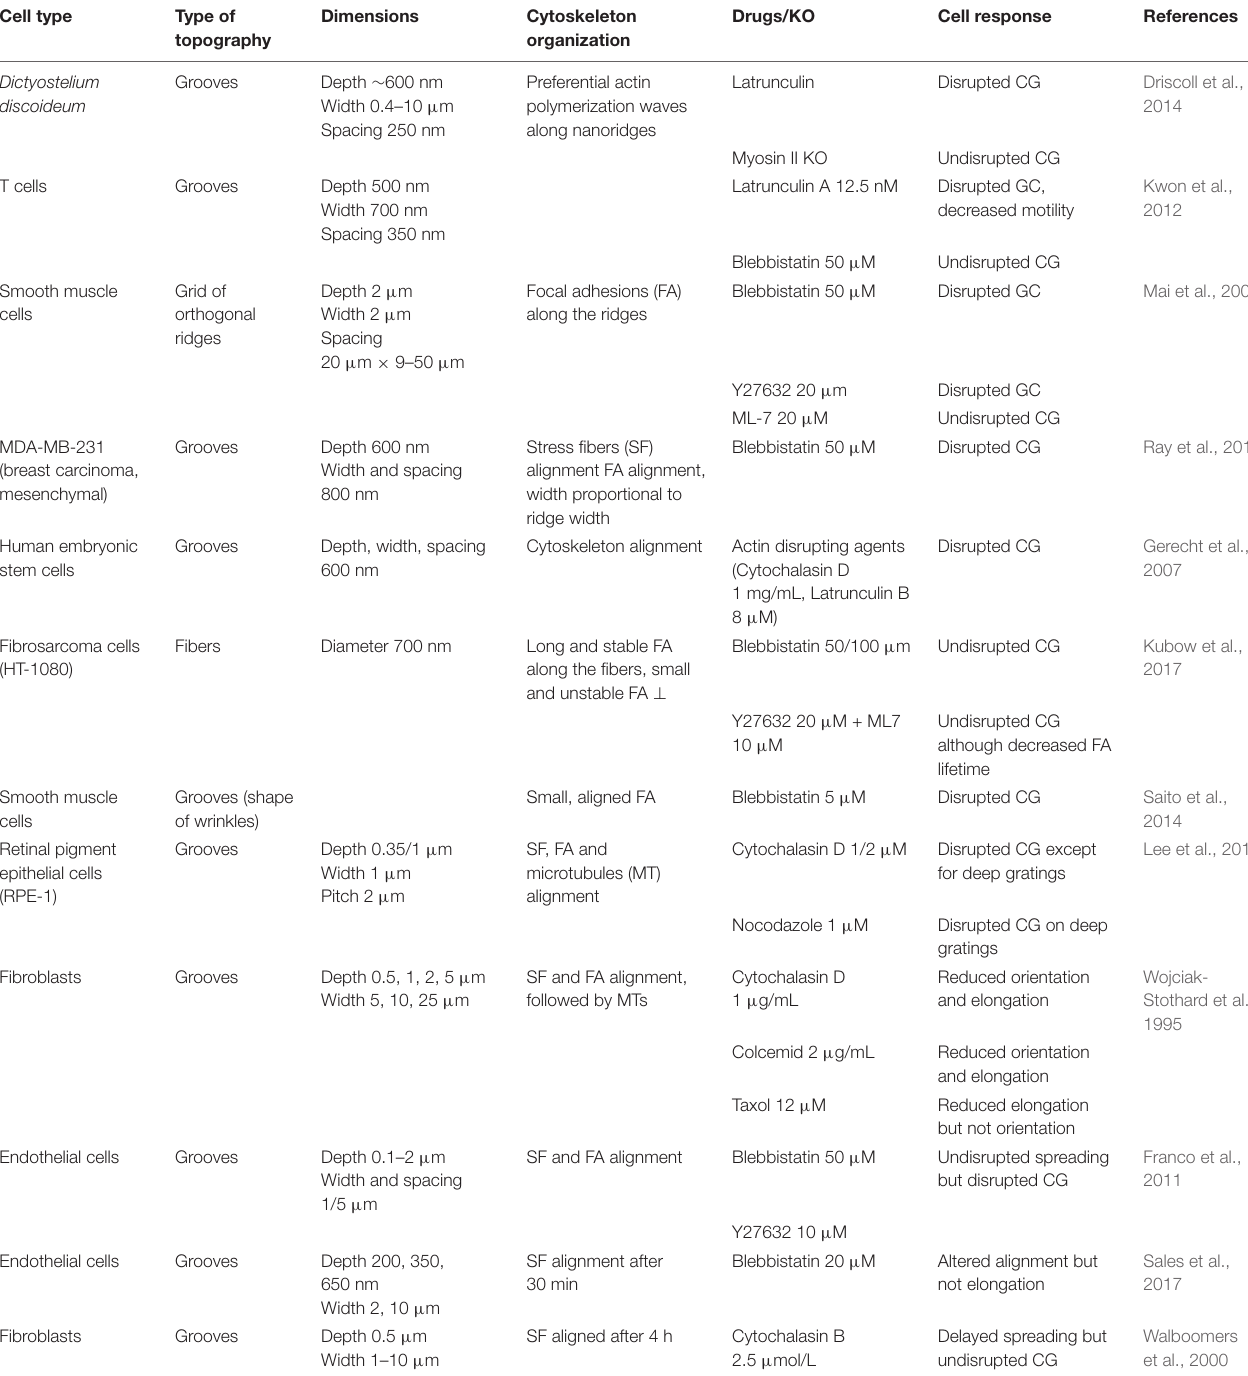
TABLE 4 | Cytoskeleton organization and effect of cytoskeleton inhibitors on contact